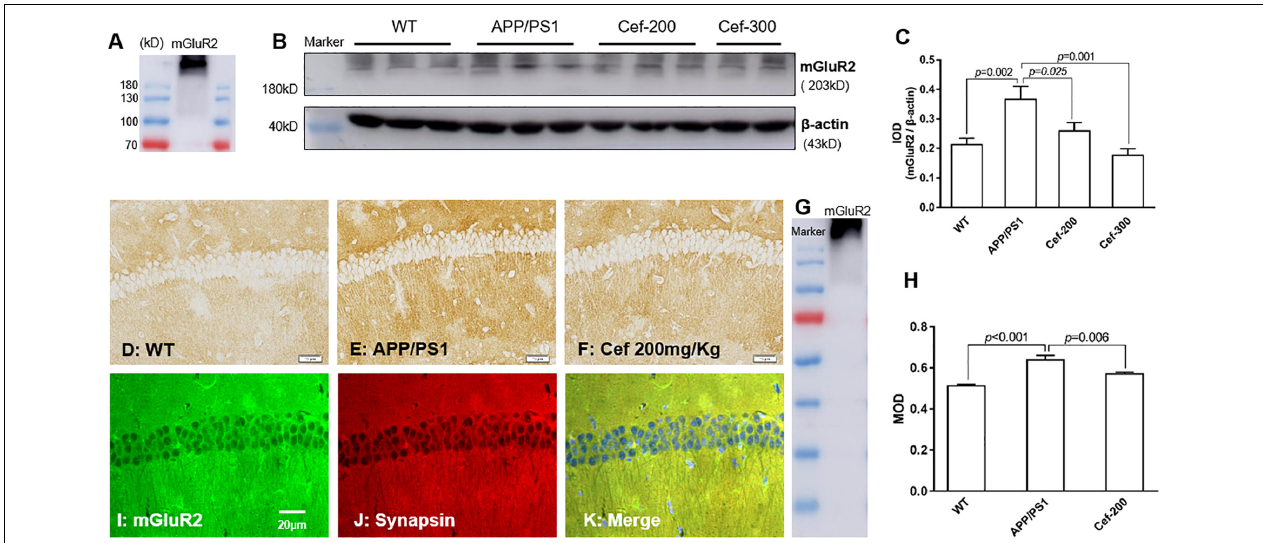
FIGURE 2 | Cef suppresses the expression of mGluR2 in protein level in the hippocampus of 6 month-old APP/PS1 mice. (A) Is an mGluR2 band to indicate the expression of dimeric mGluR2 (230 kD). (B) Is a representative immunoblot of Western blot in each group, and (C) is the quantitative presentation of the immunoblot with integral optical density (IOD). (D–F) Are representative photomicrographs of immunohistochemistry staining in each group and the scale bar on them is 20 µ m. (G) Is a western blot band of mGluR2 to indicate the immunohistochemistry stain is specific for mGluR2. (H) Is the quantitative presentation of the immunohistochemistry staining with mean optical density (MOD) in each group. (I–K) Are representative photomicrographs of double immunofluorescent labeling staining of mGluR2 and synapsin in WT mice. The number of mice for each test is shown in Table 1 . mGluR2, metabotropic glutamate receptor 2. The italic values upon the bars are statistical P